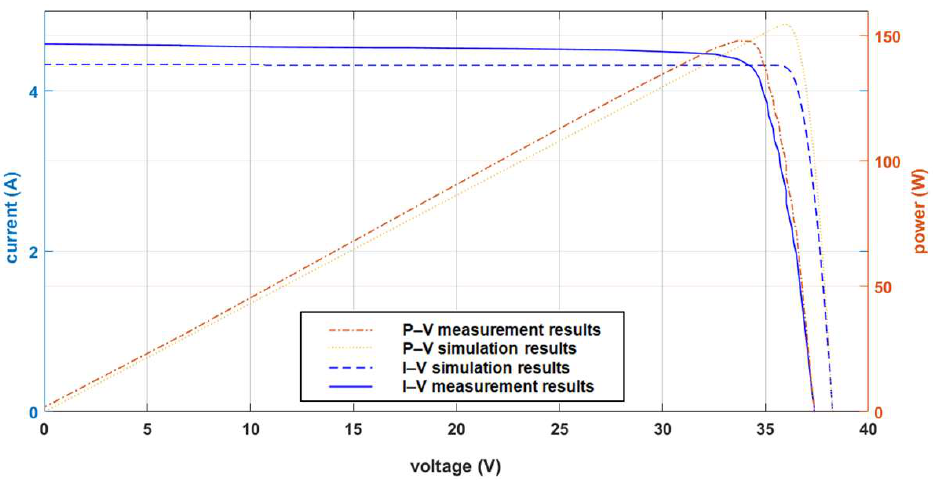
Figure 8. Verification results for measuring point P5 (see Table 2).